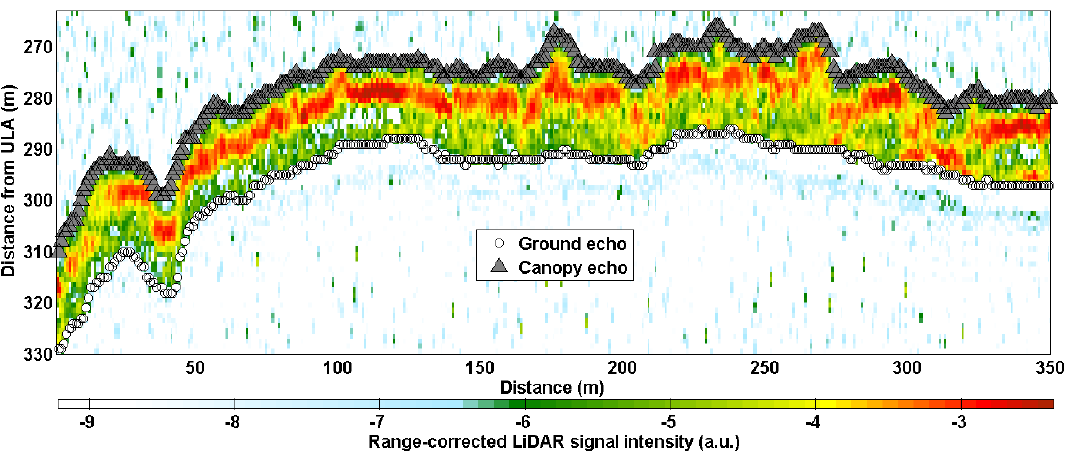
Figure 3. Example of ground echo and canopy top detection from a range-corrected LiDAR signal explained in arbitrary units (a.u.) for a section of flight over the tropical forest of Bélouve (BF). The difference between the ranges of these two points yields the canopy height (CH). Note that the y-axis is not the ground elevation, but the distance from the emitter. ULA, ultra-light aircraft.